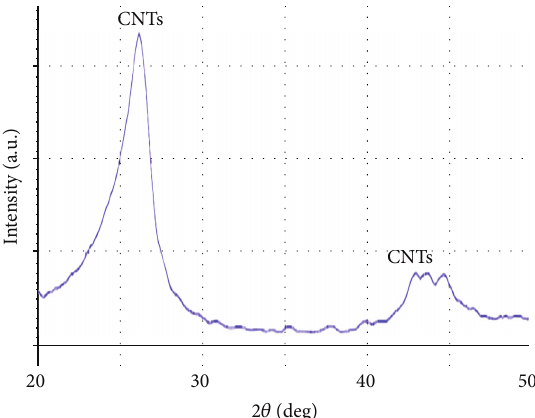
Figure 2: X-ray diffraction of CNTs produced.